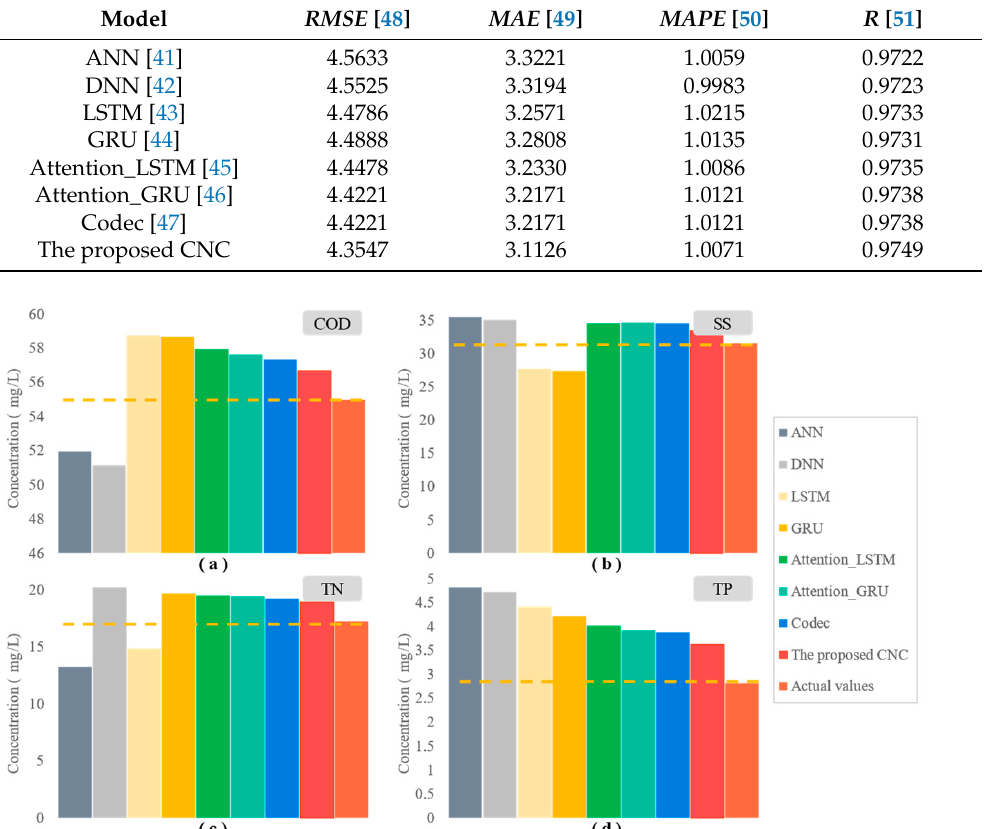
Table 1. Comparison of evaluation indexes based on prediction results of actual brewery wastewater pollutant index data.